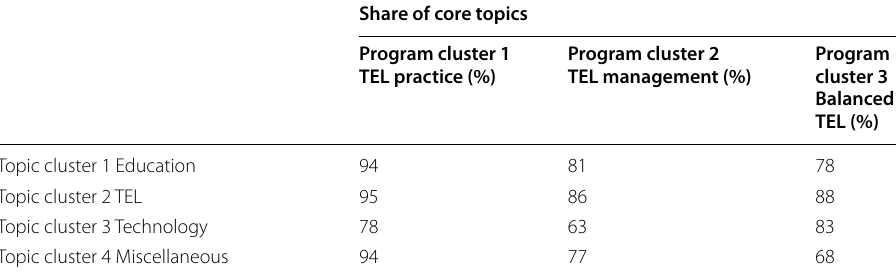
Table 2 The ratio of core and elective topics from each topic cluster in each program